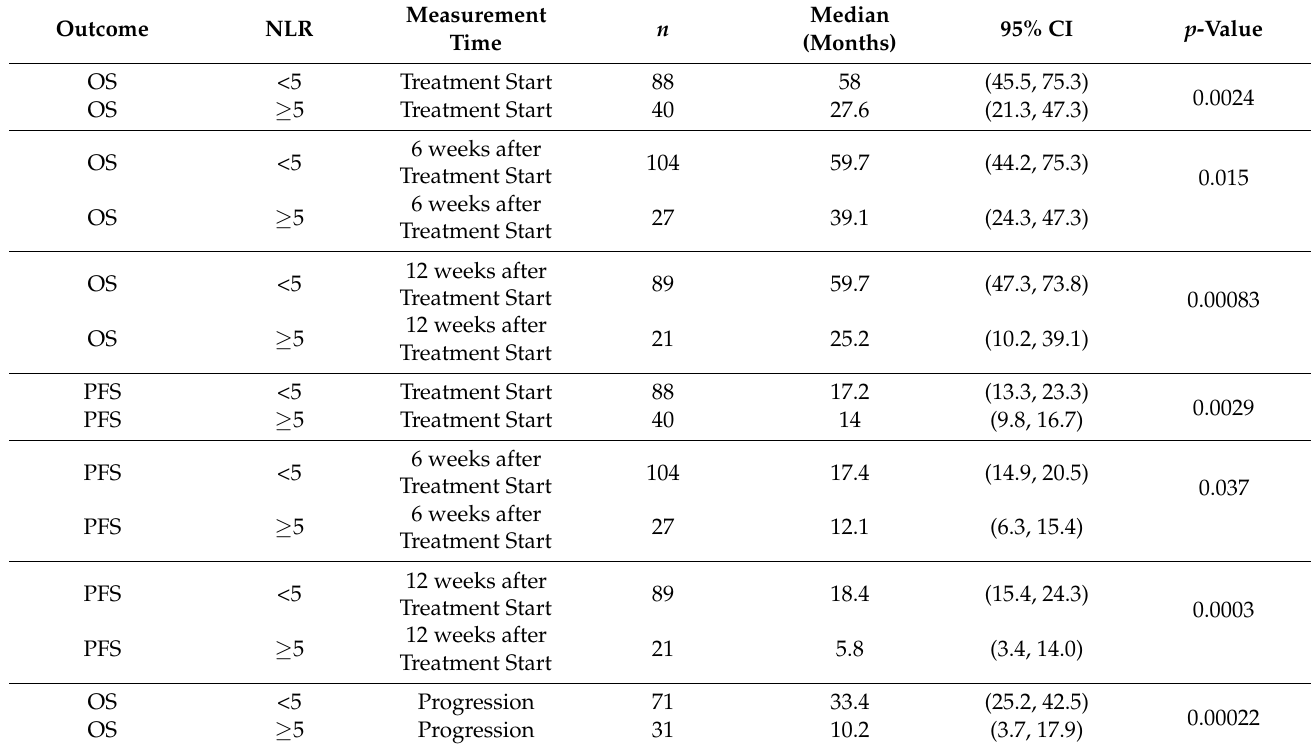
Table 3. Progression free survival (PFS) and overall survival (OS) for patients with NLR ≥ 5 and < 5 at therapy start, 6 weeks and 12 weeks after beginning